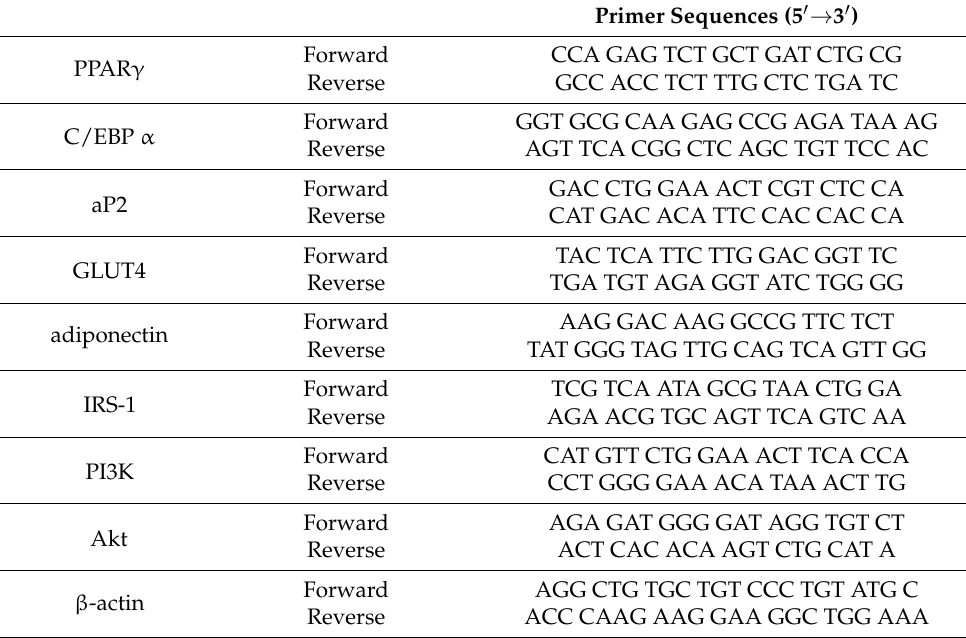
Table 1. Gene-specific primers used for RT-PCR.